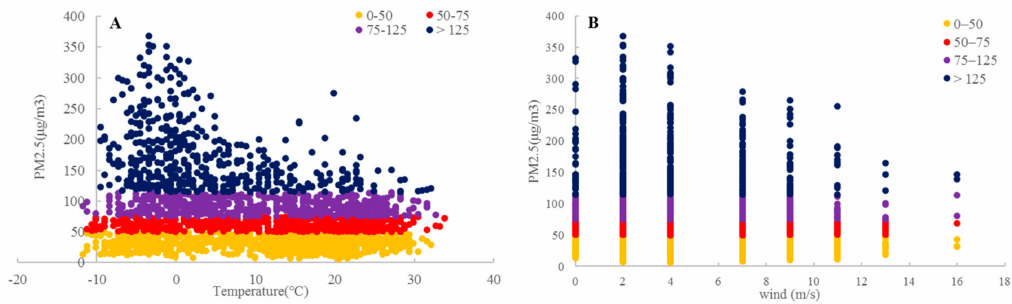
Figure 11. Correlations between the PM 2.5 concentration and meteorological factors. ( A ) temperature; ( B ) wind